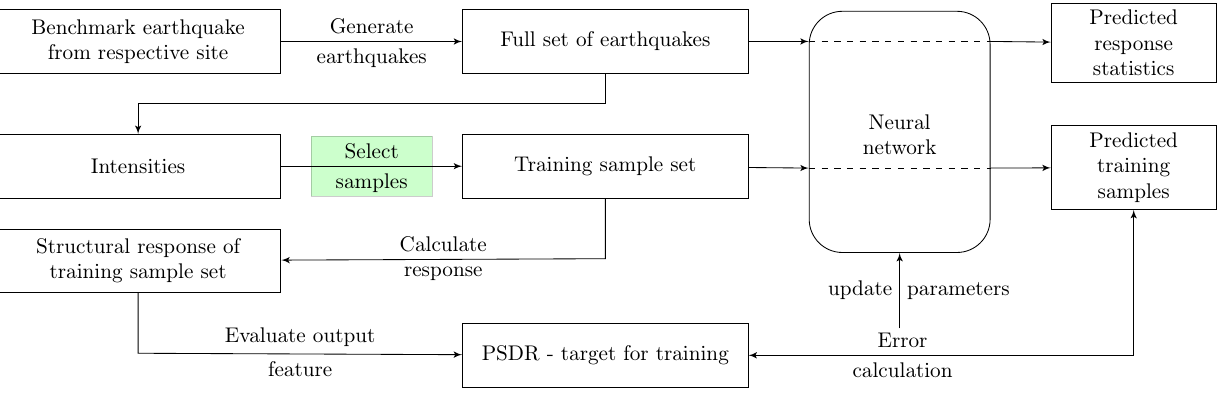
Figure 6. Flowchart of machine learning enhanced structural response statistics using the proposed strategy for the selection of the training samples during supervised